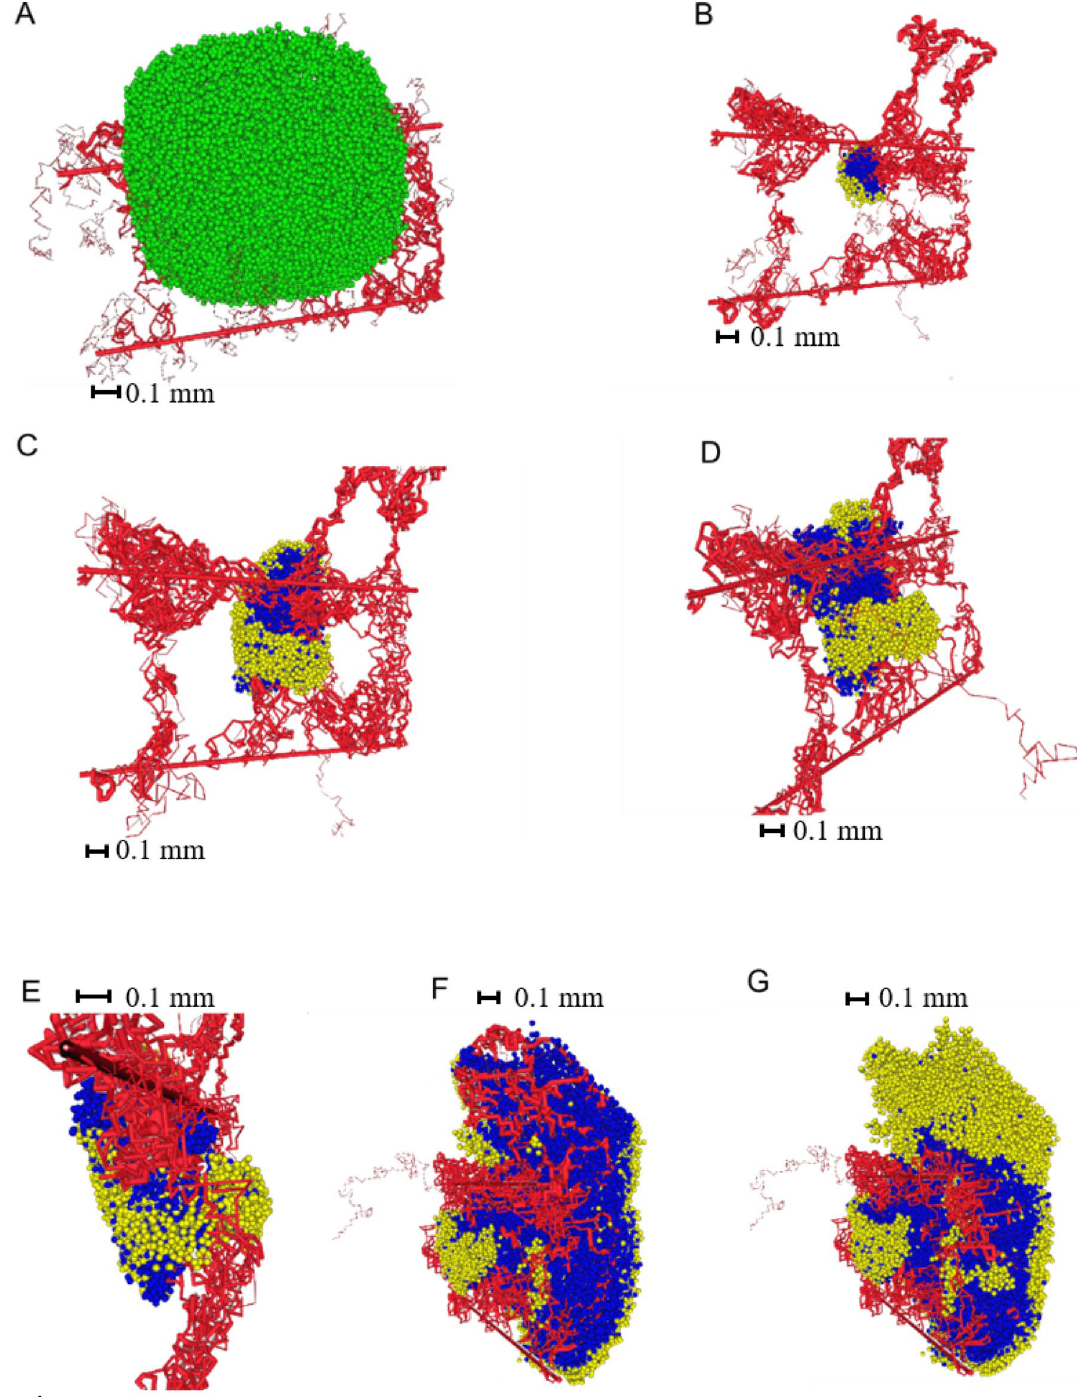
Figure 4. Three-dimensional growth of the tumour. ( A ) Healthy tissue embedded between 2 parent vessels results in efficient angiogenesis and a sufficient oxygen supply. ( B ) The initial tumour is implanted in the healthy tissue. For ease of visualization, only tumour cells are shown (blue: proliferating tumour cells, yellow: quiescent tumour cells) and healthy cells are hidden. ( C–E ) Further vascular tumour growth. ( F,G ) Different views of the tumour at final time point ( E